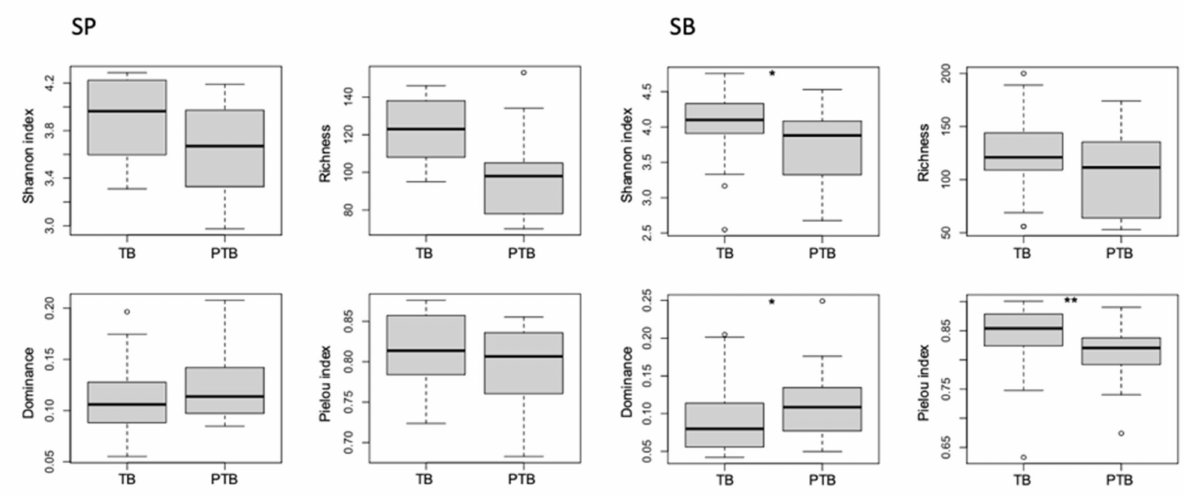
Figure 3. Impact of the groups on alpha-diversity, richness, evenness and dominance of supragingival (SP) and subgingival (SB) plaque. Note: SP = supragingival; SB = subgingival; TB = Term birth; PTB = Preterm birth; * p < 0.05; ** p < 0.01; ◦ =